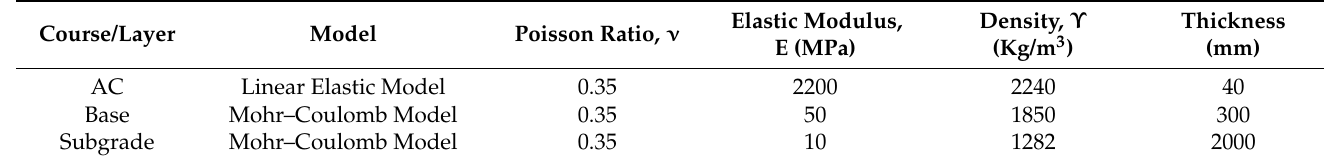
Table 1. Material properties for the base, subgrade [26,27], and AC [28].